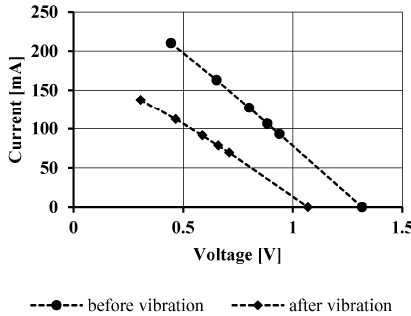
Figure 12. Comparison V - I -characteristics of the big bulk device between before and after the vertical vibrations.